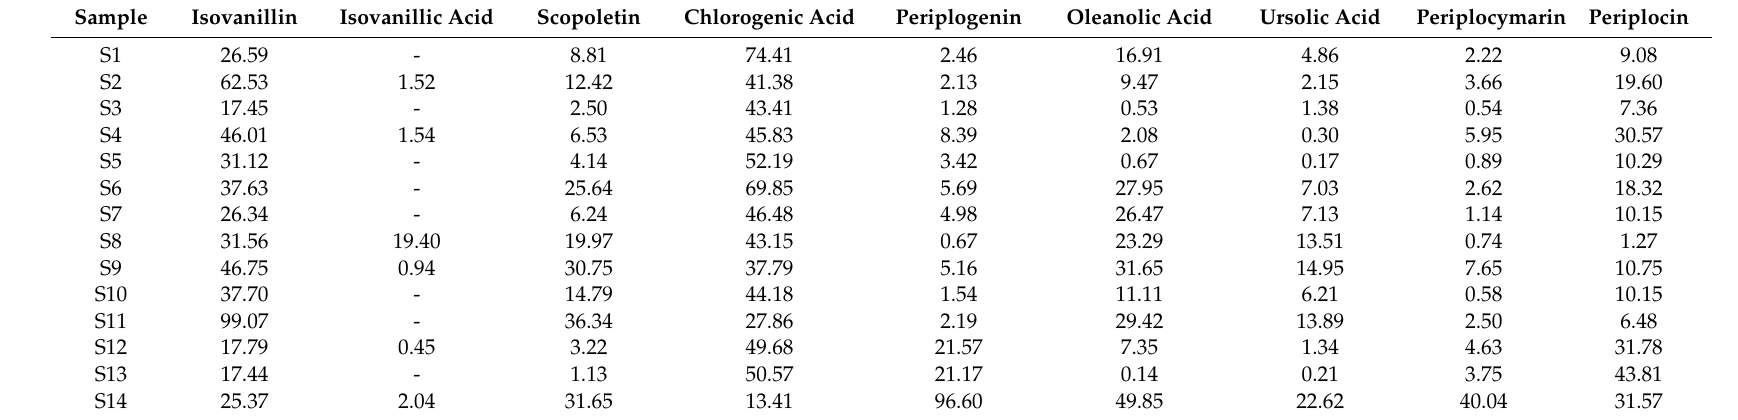
Table 4. The contents of nine components in Cortex Periplocae from di ff erent areas ( µ g · g − 1